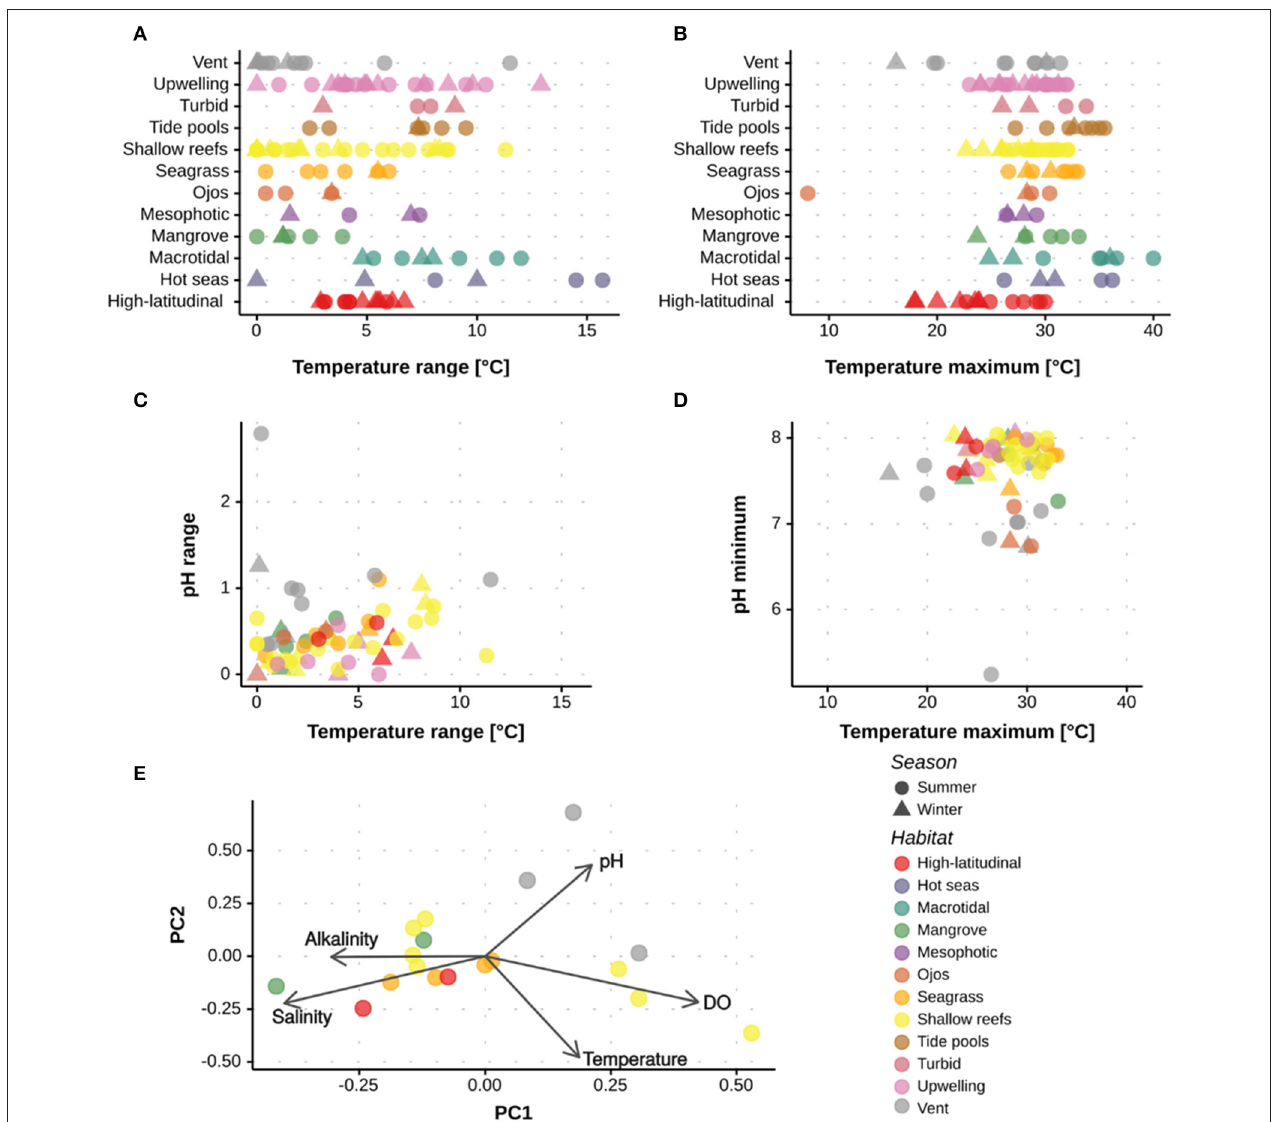
FIGURE 4 | Quantitative assessment of the abiotic conditions experienced at the different extreme and marginal environments. Data are shown for studies out of the 285 assessed that reported the maximum, minimum or range in (A,B) temperature, (C,D) temperature and pH, and (E) temperature, pH, A T , salinity and oxygen. Data are shown per season and environment. Supplementary Table 1 and Supplementary Figure 1 have the references for the data